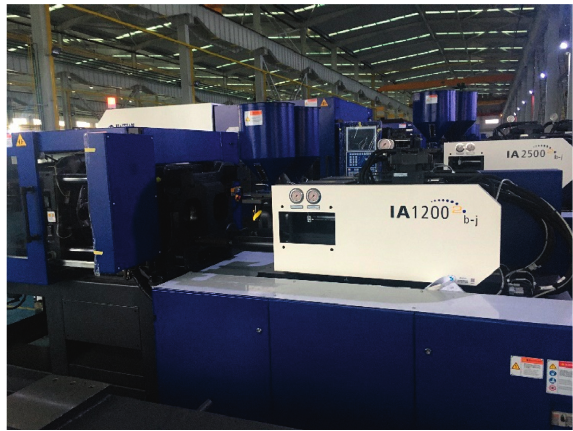
Figure 8: IA1200 series.injection molding